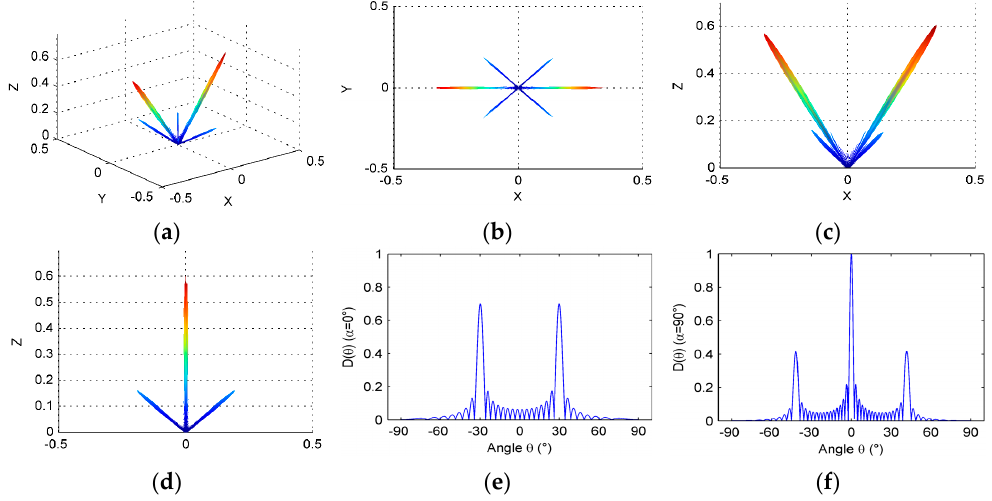
Figure 12. Directivity of linear phased array: ( a ) three-dimensional directivity; ( b ) directivity pattern in x - y plane; ( c ) directivity pattern in x - z plane; ( d ) directivity pattern in y - z plane; ( e ) directivity pattern when α “ α 0 “ 0 ˝ ; and ( f ) directivity pattern when α “ α 0 “ 90 ˝ .